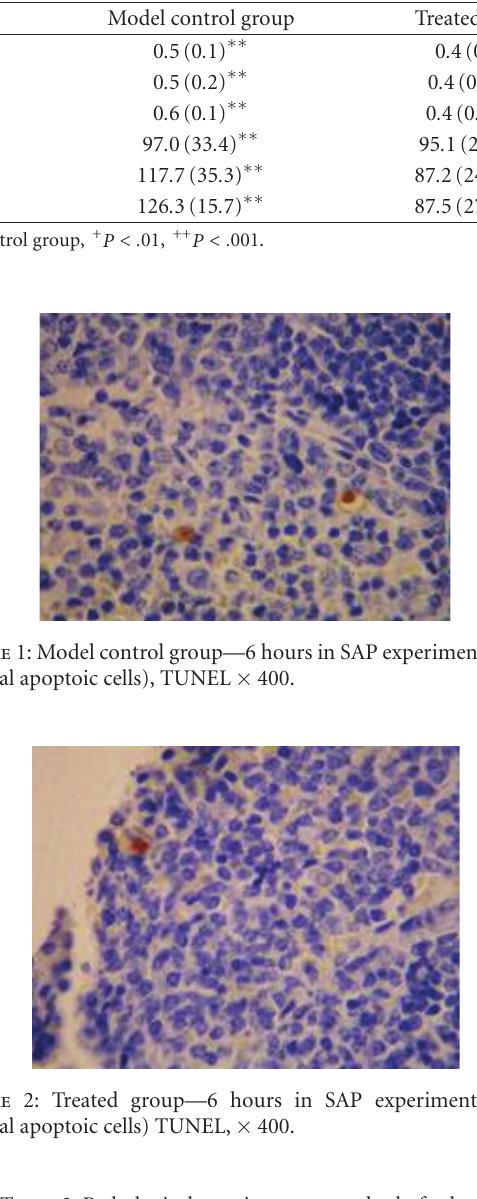
Table 2: Pathological severity score standard of